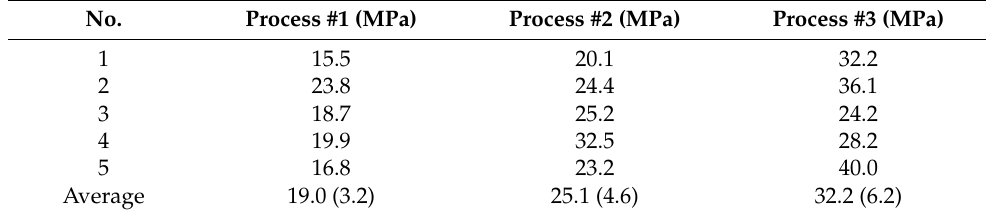
Table 7. Summary of physical property evaluation